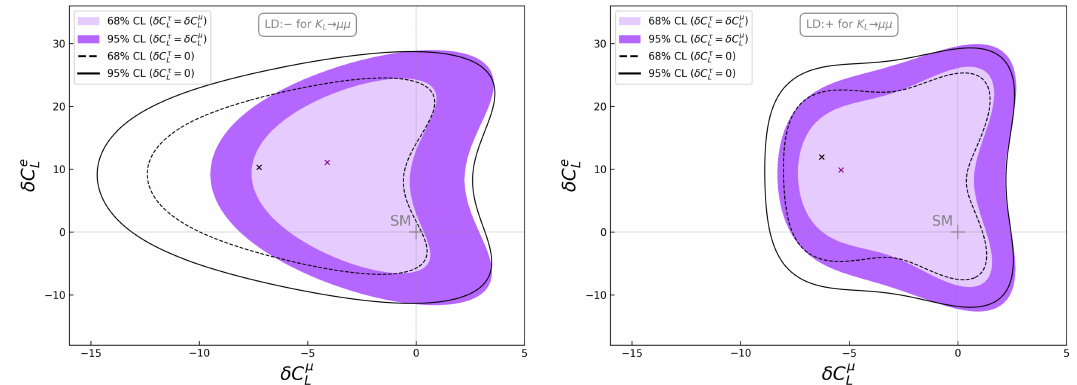
Figure 8 . Comparison of the global fits between scenarios δC τ δC τ = 0 (black solid and dashed lines). The fits are implemented using existing data with long- L distance contribution to K L → µ ¯ µ having a negative (positive) sign, on the left